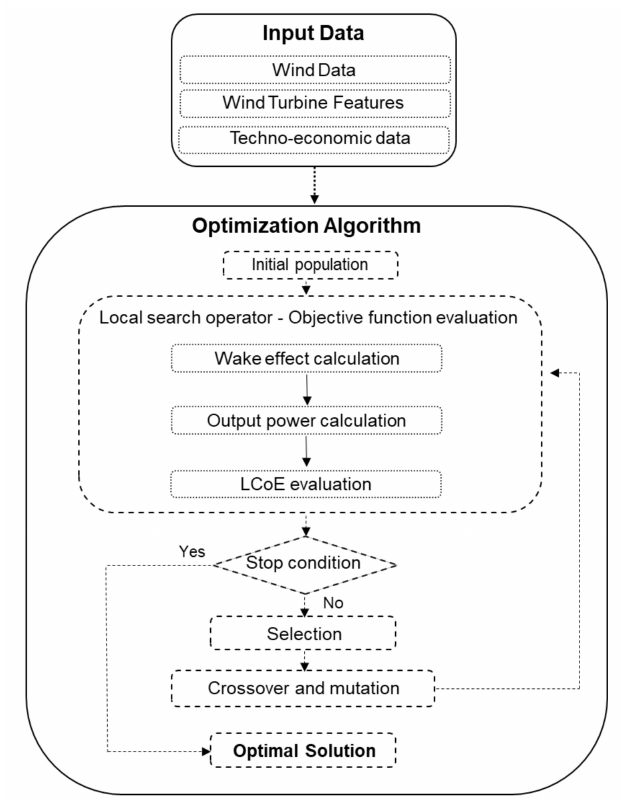
Figure 3. Flowchart of the proposed optimization